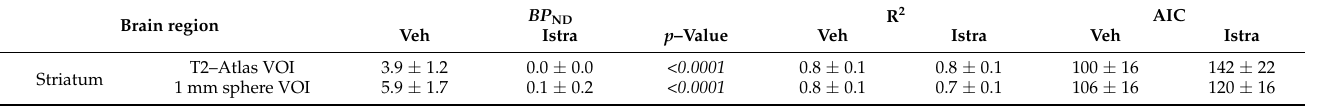
Table 3. Striatal [ 18 F]FLUDA BP ND (SRTM, using the Ma–Benveniste–Mirrione–T2 Atlas whole stri- atum template, or 1 mm diameter spherical VOI placed in the centroid of the target and reference region of vehicle (veh, n = 8) and istradefylline pre–treated (istra, n = 4) healthy CD–1 mice.